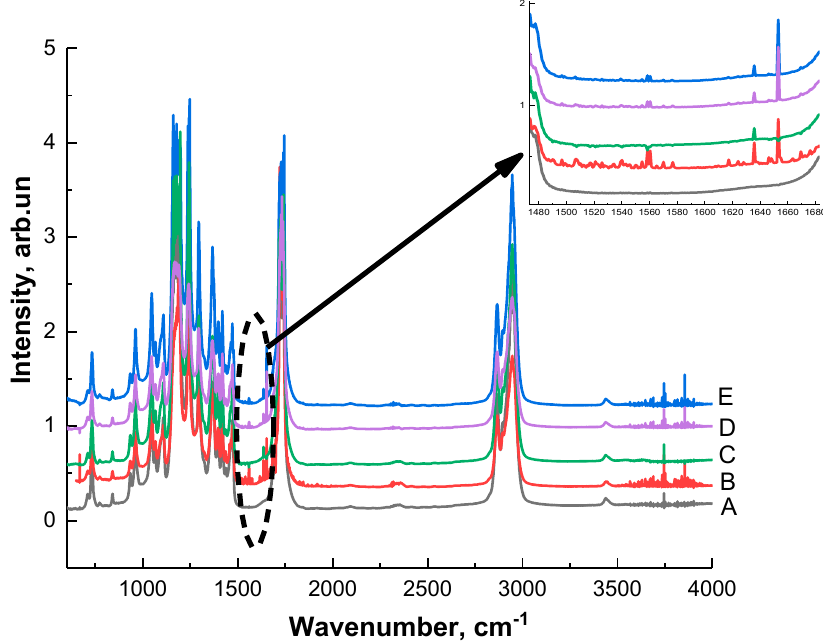
Figure 3. Fourier transform infrared spectra of the various films: (A) unmodified poly(“-caprolactone), (B) PCL treated with the 0.25 M arginine solution in water for 24 h at T = 25 °C, (C) PCL treated with the 0.25 M arginine solution in isopropanol for 24 h at T = 25 °C, (D) PCL treated with the 0.25 M arginine solution in water for 1 h at T = 40 °C, (E) PCL treated with the 0.25 M arginine solution in isopropanol solution for 1 h at T = 40 °C. The two additional peaks in the range from 1550 to 1650 cm − 1 in aminolyzed PCL films indicated the introduction of amine groups onto the PCL substrates.